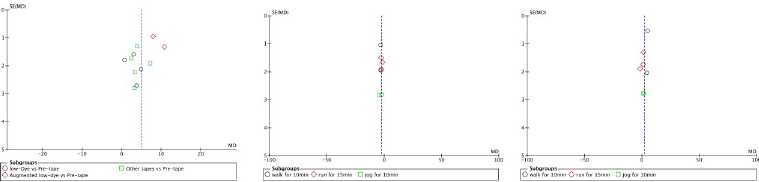
Fig 1. Funnel plots of included studies. (A) Navicular height Post tape VS pre-tape. (B) Navicular height post exercise VS immediately post tape. (C) Navicular height post exercise VS pre-tape.